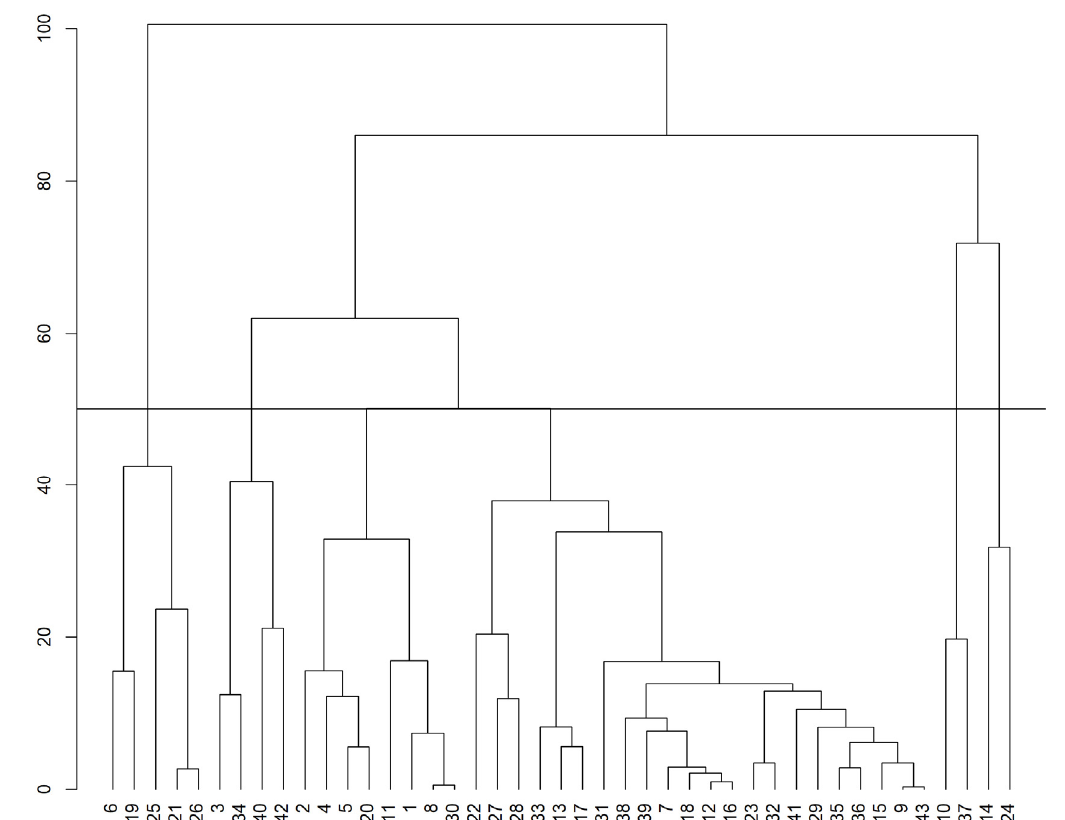
Figure 2. Dendrogram representative of genetic dissimilarity among 43 genotypes of Coffea canephora , obtained by the UPGMA clustering method, using the generalized distance of Mahalanobis (D²) and a cut-off point at 50%, considering four leaf morpho-anatomical traits, i.e., ECD, epidermal cell density (cells mm − 2 ); SD, stomata density (unit mm − 2 ); SL, stomatal length (major axis; μ m); SW, stomatal width (minor axis; μ m).